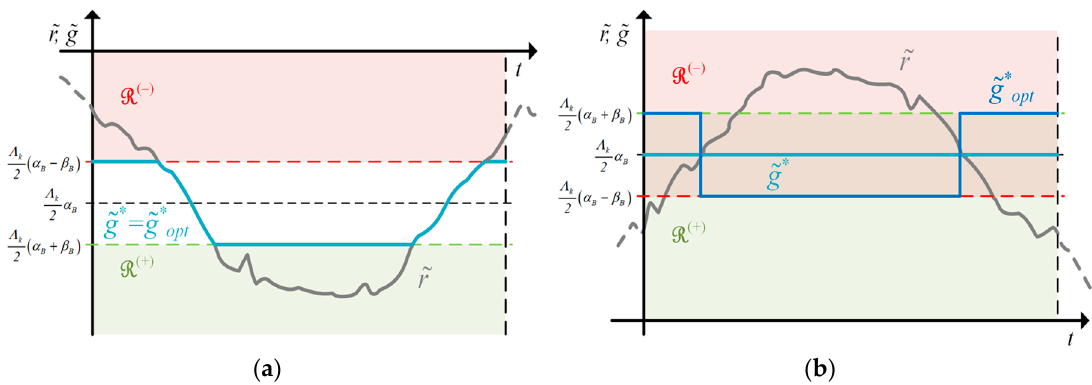
Figure 3. The two plane regions R (+) and R ( − ) for different r and Λ k values, together with optimal ( g ̃ * opt ) and sub-optimal ( g ̃ * ) grid profiles achieved assuming that no B power limitation occurs: ( a ) negative r and Λ k ; ( b ) positive r and Λ k . Table 1. Optimal solution in accordance with both Λ k and r .